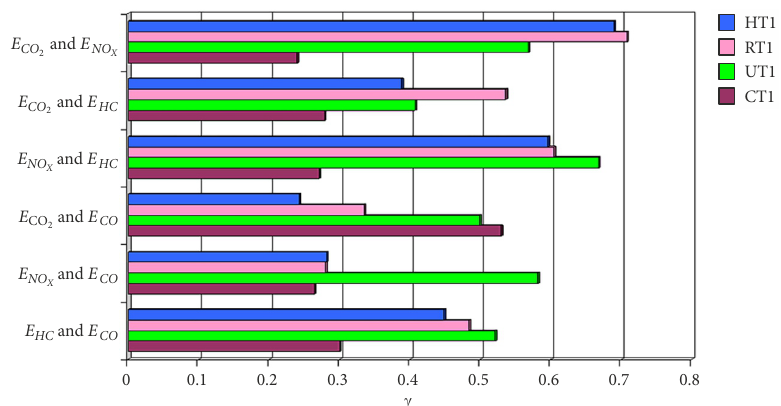
Figure 21. Coefficient of Kruskal’s gamma correlation g between the emission intensity of specific pollutants , E NO , E CH , E CO ) in individual tests (CT1, UT1, RT1, ( E CO 2 X